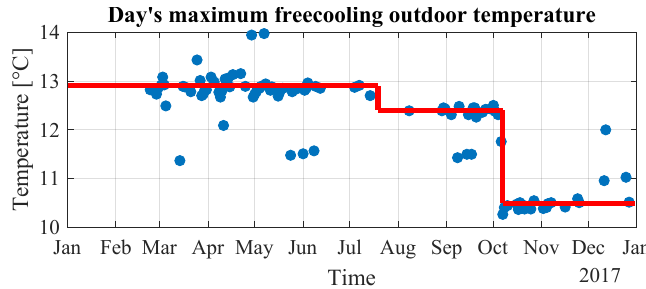
Figure 22. Maximum outdoor temperatures in freecooling mode—Turbocor